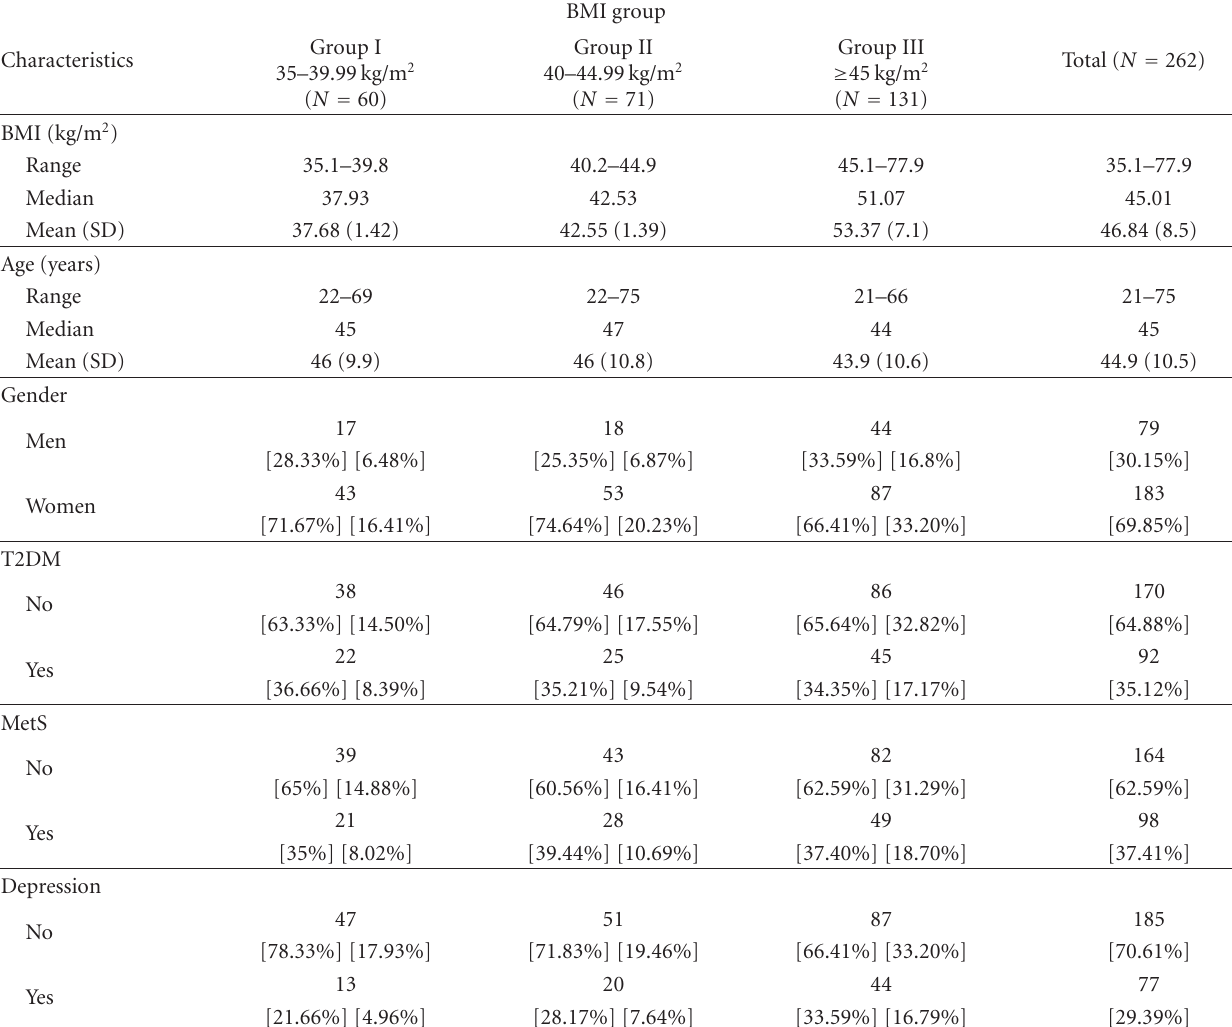
Table 1: Selected patient characteristics and patient distribution by body mass index (BMI) group, gender, and presence of